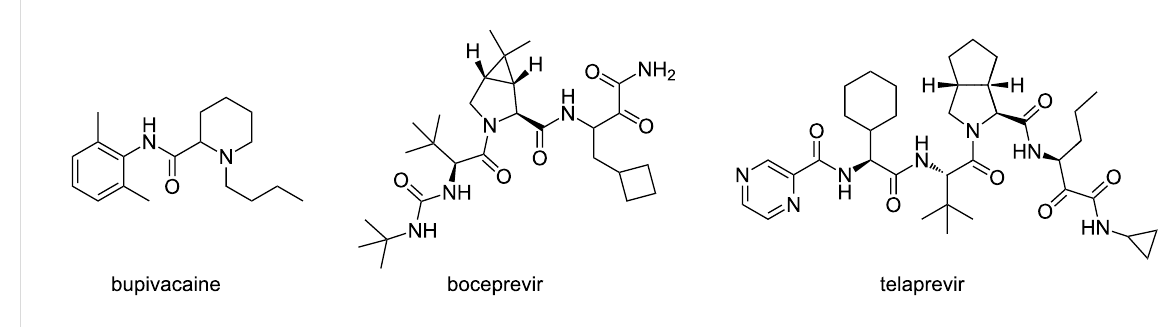
Figure 1: Examples of drugs embodying unnatural amino acids.